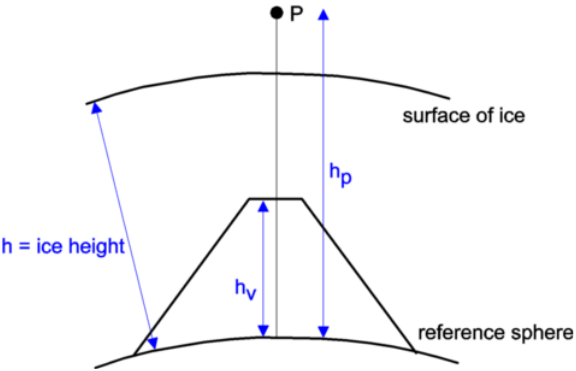
Figure 10. A model of volcano for investigation of the attenuation of the gravitational signal (in D g and T served from the point P